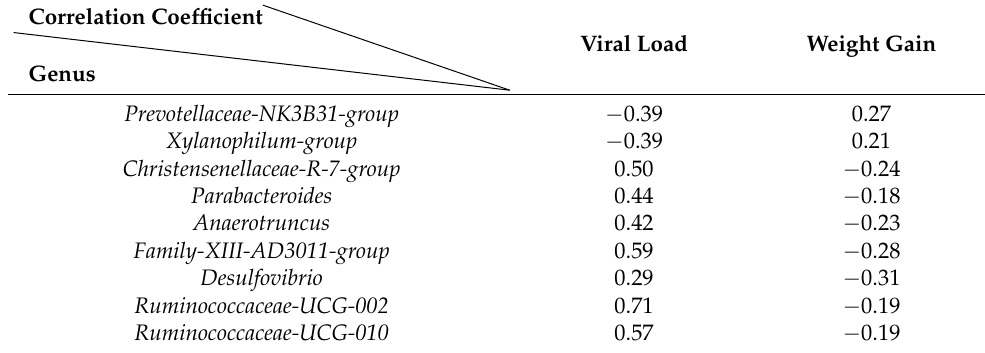
Figure 2. Heatmap analyses of gut microorganisms associated with viral load and weight gain. Spearman’s correlations among the weight gain, viral load, and the microbial genera. The color of the spots in the right panel represents the correlation coefficients ( ρ ) of the genera with viral loadand weight gain. Table 1. The co-correlative key gut microbiota between viral load and weight